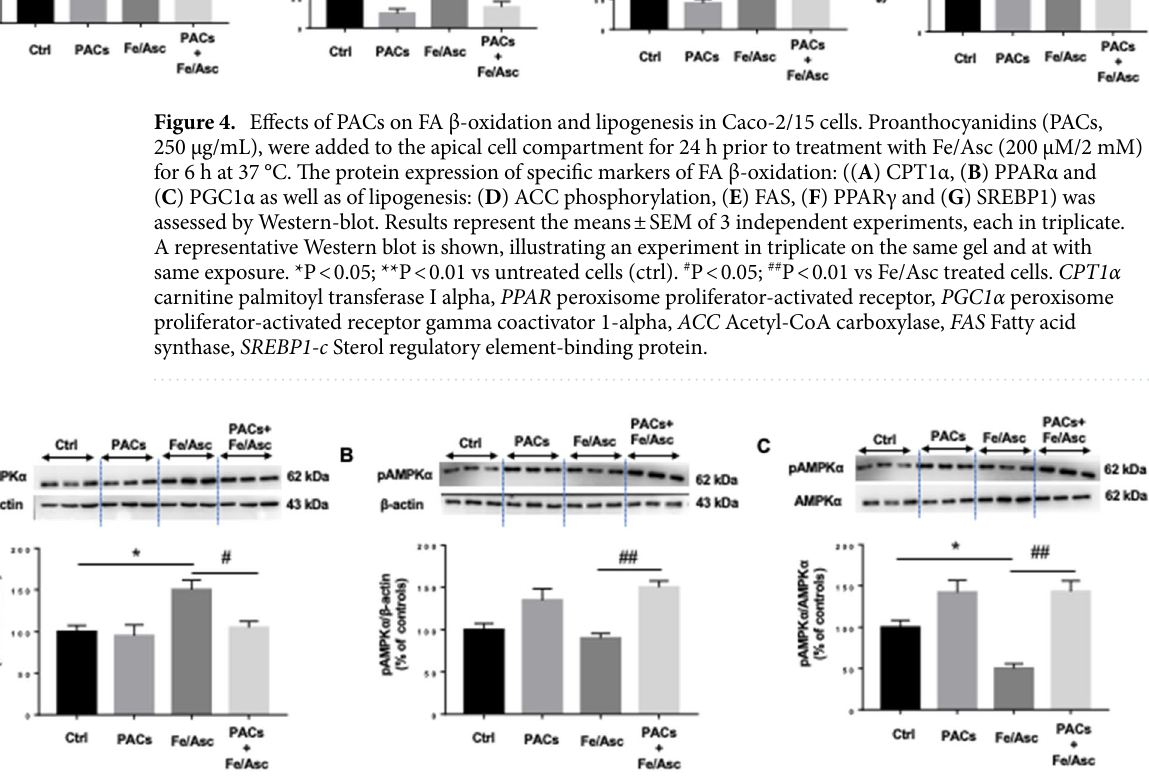
tein expression using Western blot. Figure 6 shows that the addition of Fe/Asc to Caco-2/15 cells raised the level of the two important enzymes, but PACs counterbalanced their Fe/Asc-induced upregulation. Since insulin signaling modulates the processes of lipogenesis, FA β-oxidation and gluconeogenesis, it was important to investigate the influence of Fe/Asc and PACs on MAPKs and PI3K/Akt, the two main insulin signaling pathway. To this end, Caco-2/15 cells were pre-incubated with insulin before the other Caco-2/15 cell